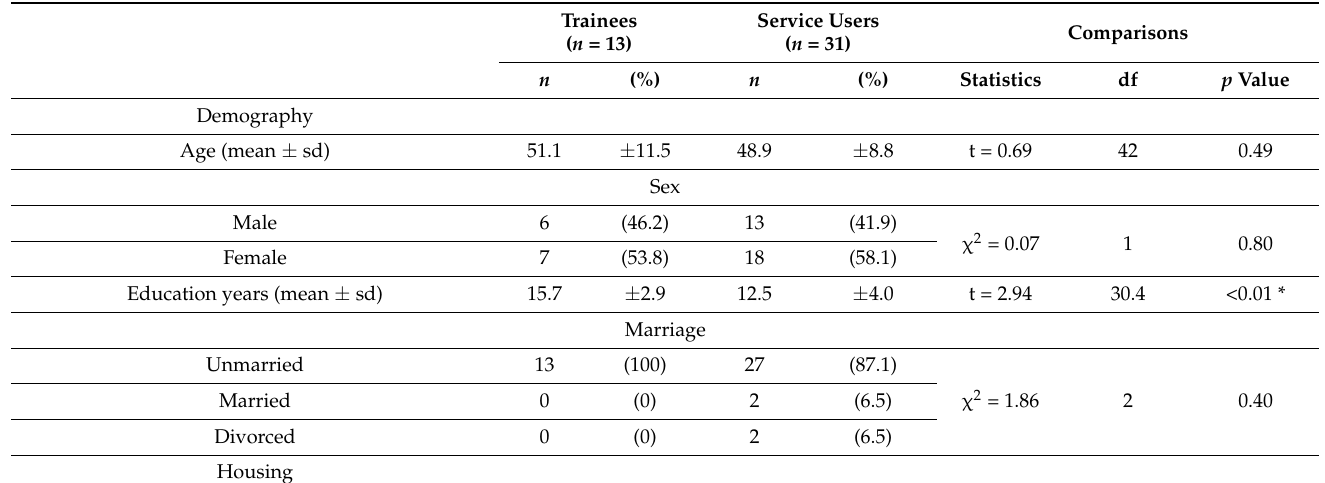
Table 2. The characteristics, psychiatric history, and measured outcomes among trainees and service